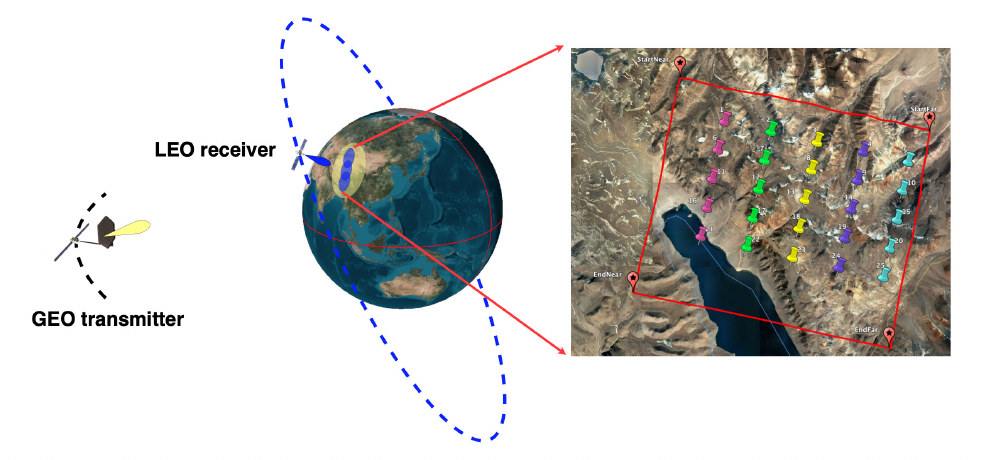
Figure 4. The target geolocations obtained from GTLR-BiSAR RD equation.